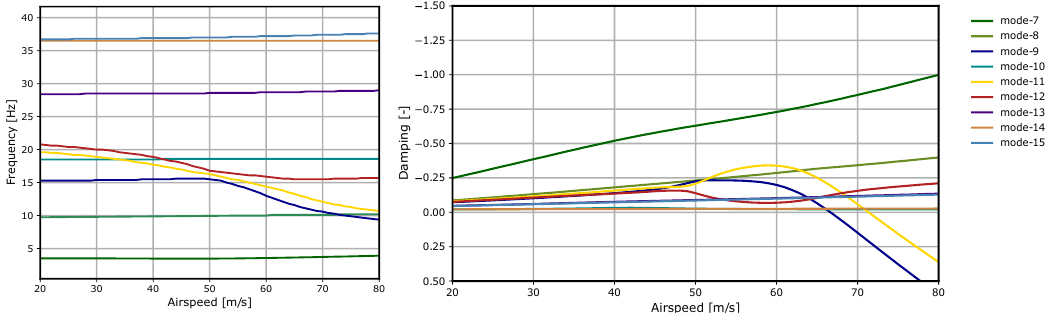
Figure 11. Frequency-( left ) and damping-velocity plot ( right ) of the aeroelastic eigenmodes. Eigenmode 1 to 6 are rigid body modes.